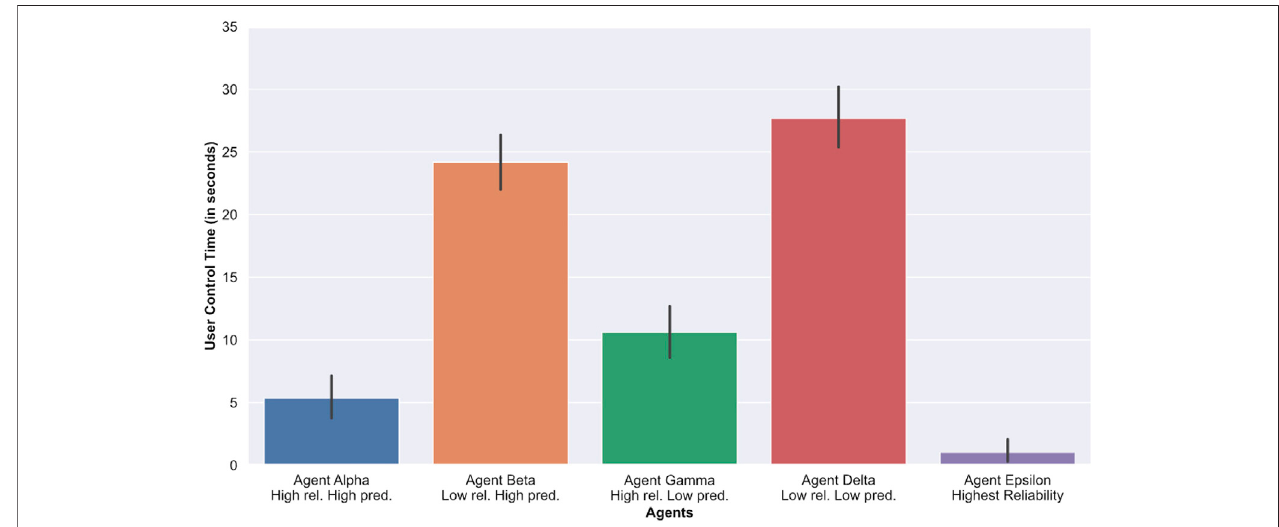
FIGURE 9 | Average reported trust in the agents. Higher scores indicate greater trust in the agents.